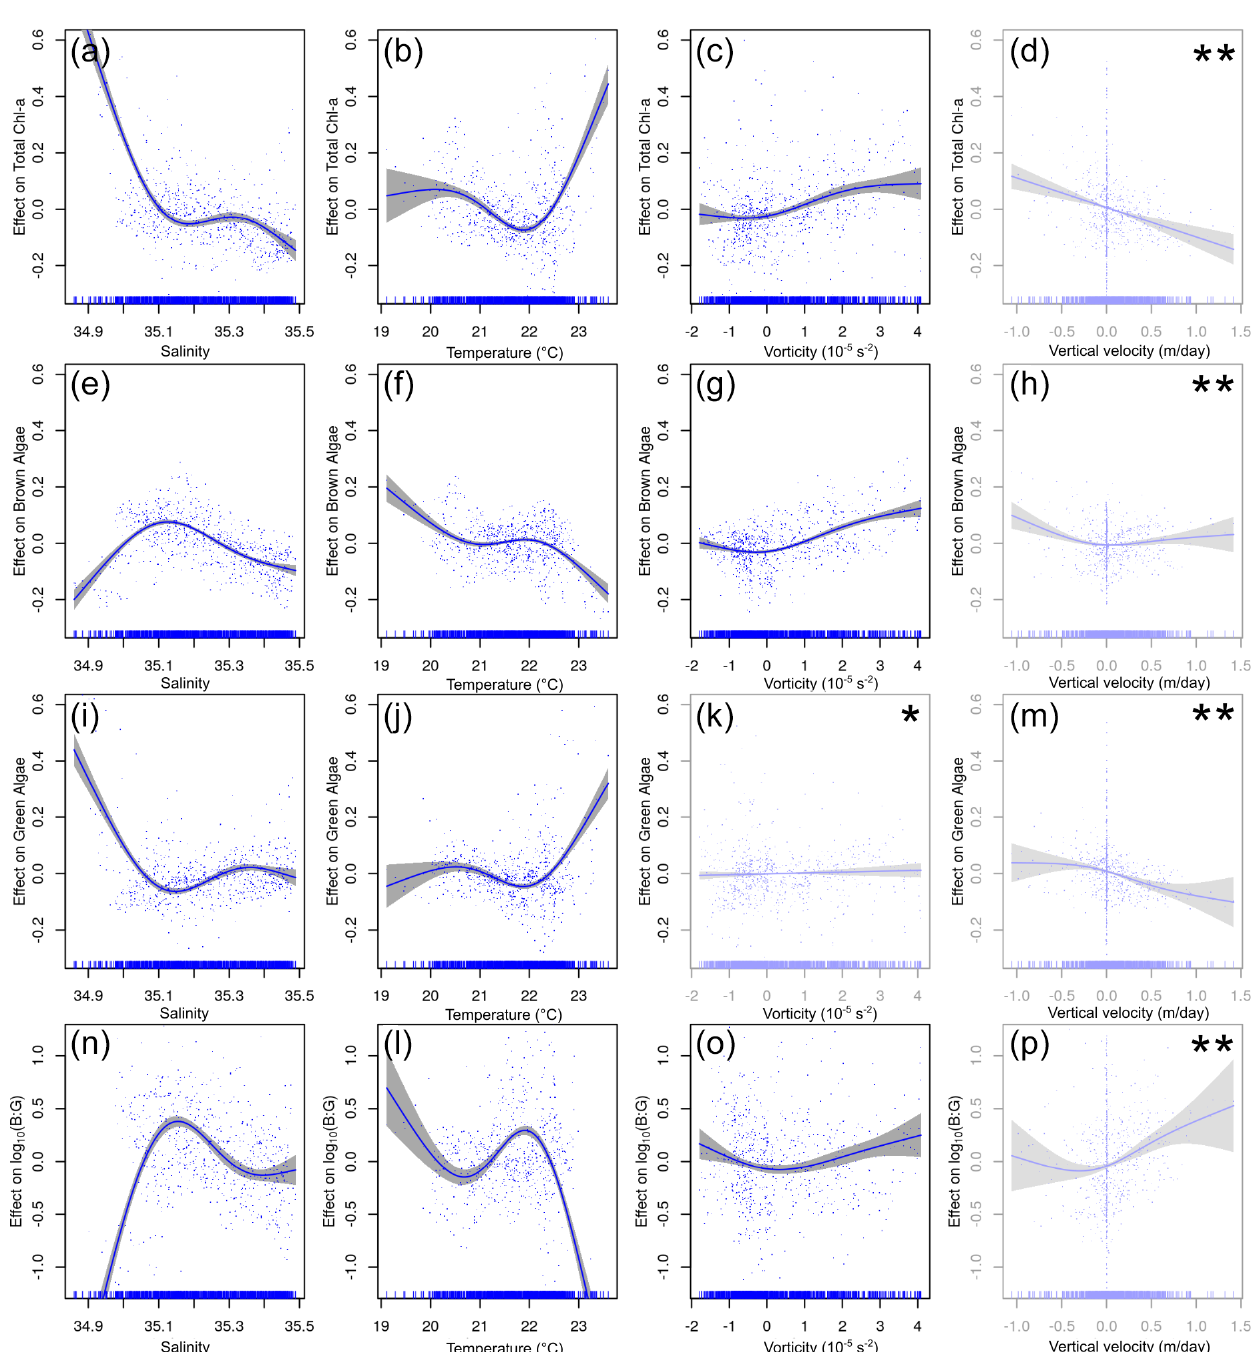
Figure 8. The relationship between environmental variables and chl a from the above the pycnocline (APY) subset GAMs. The y axis indicates the additive effect that the term on the x axis has on the chl a . The variables are given in the following order (from top to bottom): total chl a , brown chl a , green chl a , and the brown chl a to green chl a ratio (B : G). The shaded area represents the confidence interval of 95%. The effect of vorticity for green algae chl a is the only non-significant response (marked by ∗ ). The effect of vertical velocity is shown here but is not analysed further since this variable is strongly influenced (in the APY subset) by the proximity to the surface layer boundary condition assumed for its calculation (marked by ∗∗